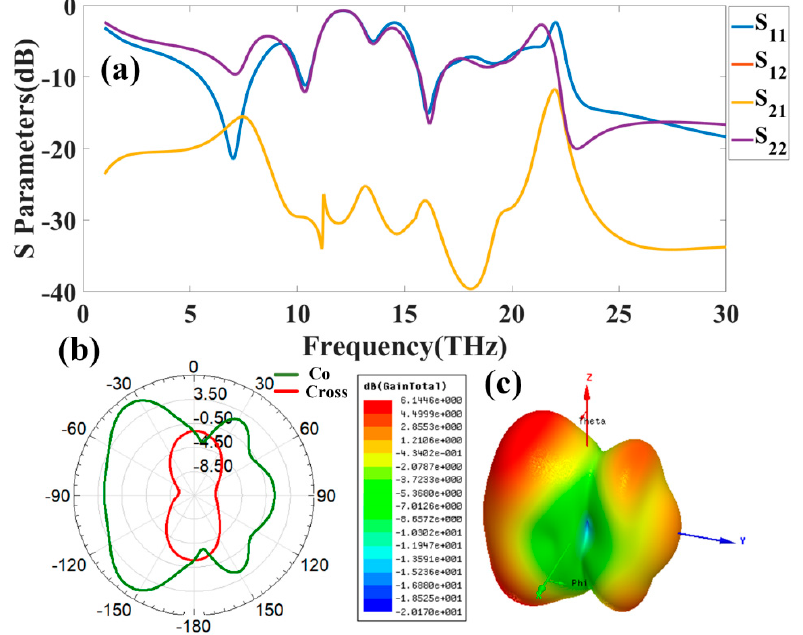
Figure A2. ( a ) Calculated S-parameters for the type-3 antenna. Calculated directivity in ( b ) 2D (with co- and cross-polarization) and ( c ) 3D, by considering single-port (Port-1) excitation.